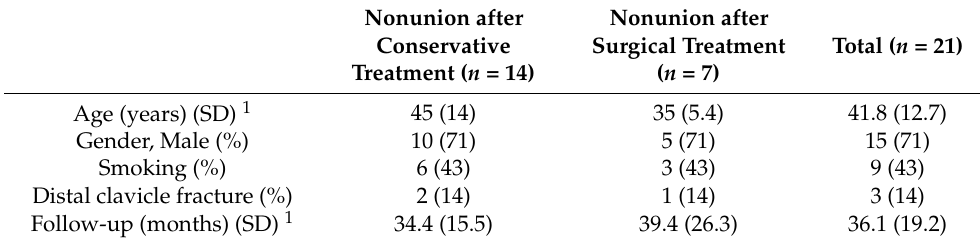
Table 1. Patient